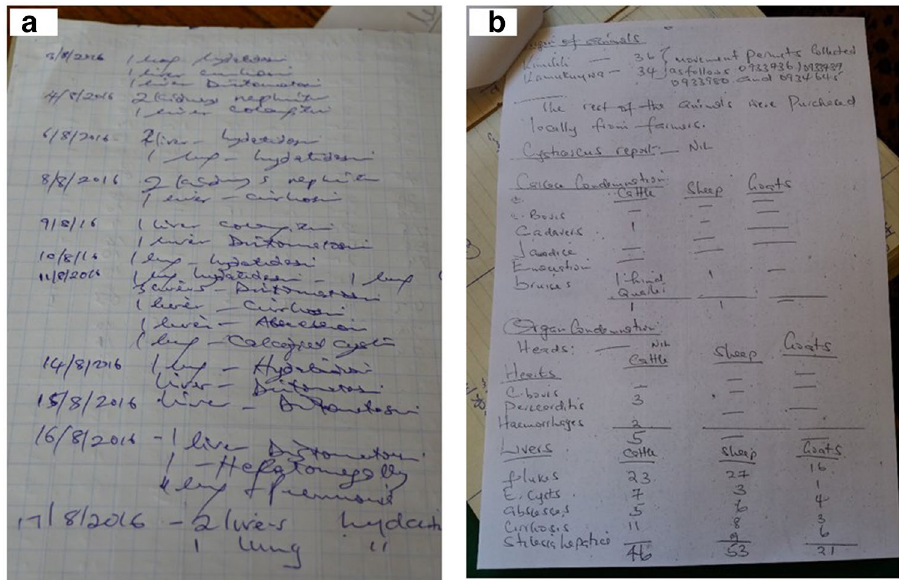
Figure 1. Daily records (a) and a monthly compilation (b) of condemnations reported in a slaughterhouse in